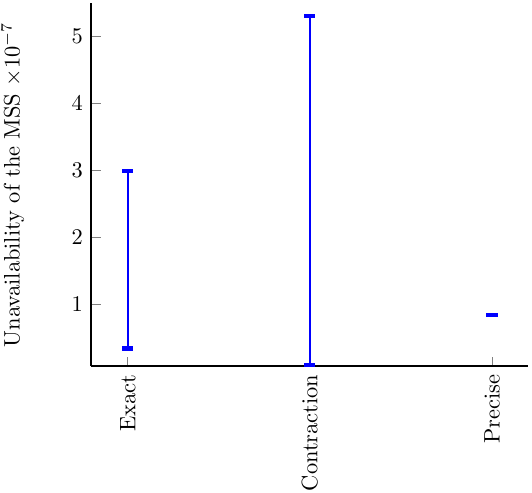
Figure 10. The unavailability of the system obtained using each